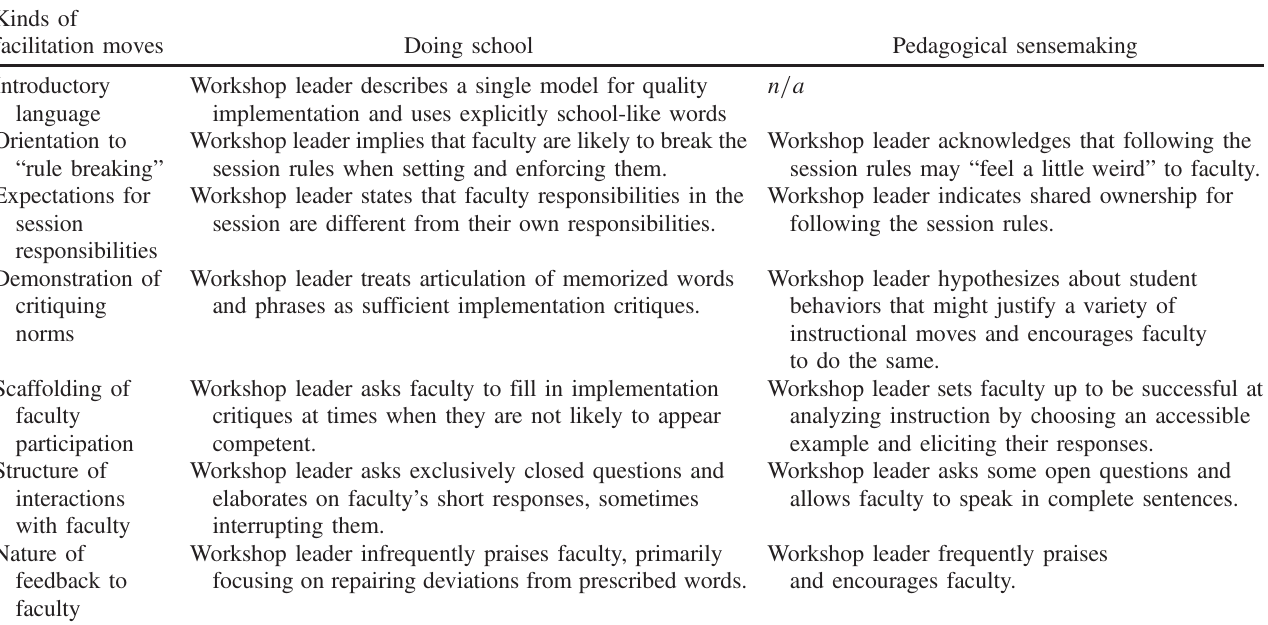
TABLE VII. Observed workshop leader facilitation moves (part of the session embodiment) that seemed to contribute to faculty engaging in doing school or pedagogical sensemaking as in Table VI.